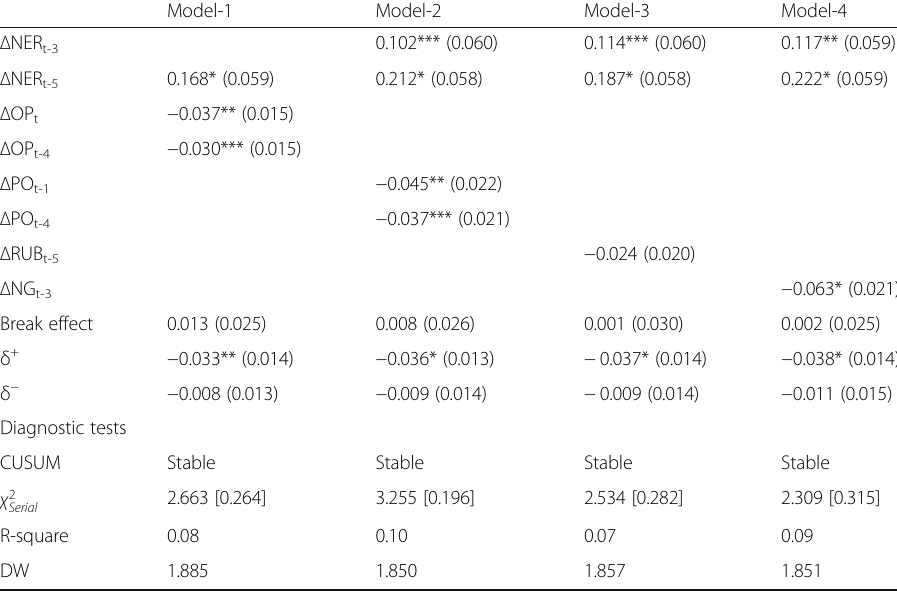
Table 7 The M-TVECM estimates